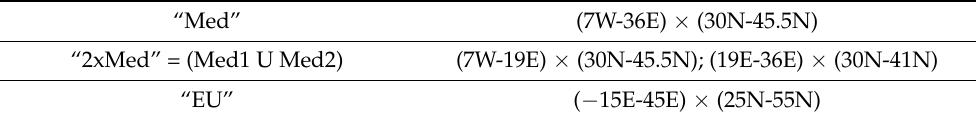
Figure 1. The domains of track origins (“EU” (black line, whole domain), “Med” (red) and “2xMed: Med1 U Med2” (orange)) and of tracks target areas (Di (i = 1–6), (blue)). Table 1. Domain of tracks’ origins.